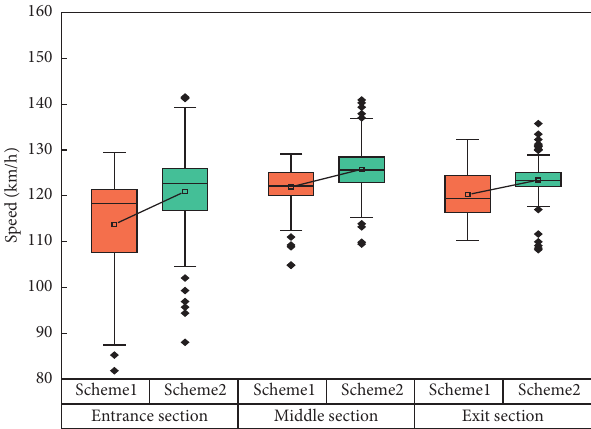
Figure 10: Speed changes in different tunnel sections for different left lateral clearance.